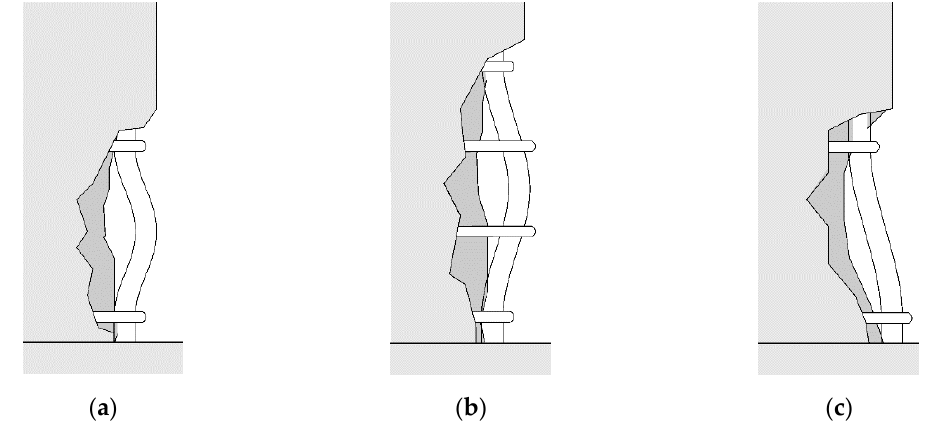
Figure 1. Shapes of buckled bars: ( a ) single tie interval without translation, ( b ) spanning three tie intervals and ( c ) single tie interval with translation [3].